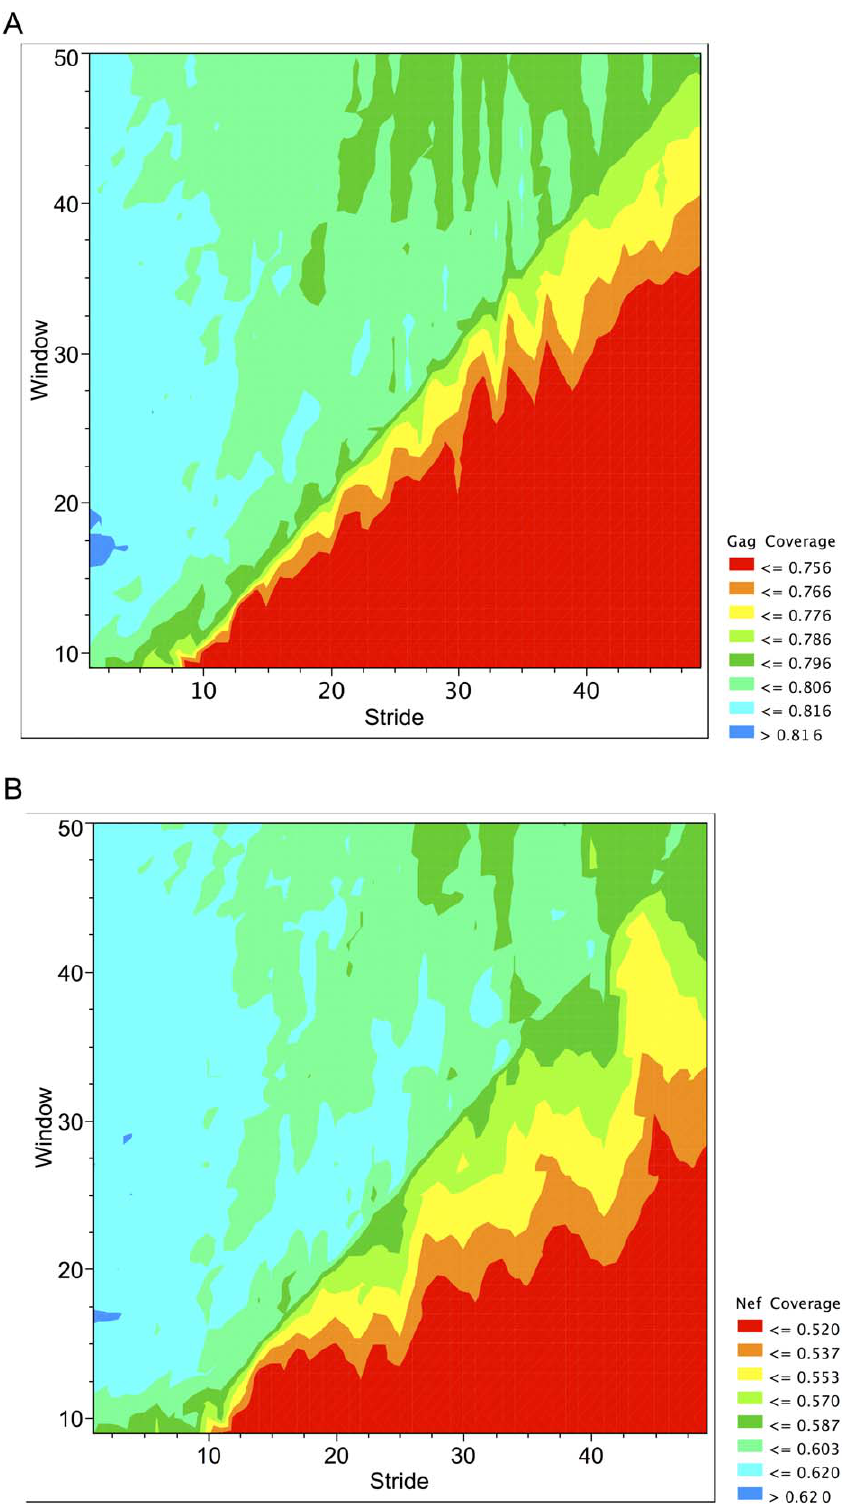
Figure 2. The Effects of Stride versus Window Length on the Measure of Coverage In each graph a three-gene-length COT þ construct is evaluated for coverage. Cold (blue) colors indicate high levels of coverage, and hot (red) colors indicate low levels of coverage. The diagonal in the topography represents the transition from strides shorter than window length to strides longer than window length. The maximal coverage at three gene lengths occurs with a window size of 17 with a stride of 1 with no smoothing for both genes— where 82% of the 9mer area is captured for Gag (A) and 62% of the 9mer area is captured for Nef (B). It should be noted that in the area of window of 17 and a stride of 1 the surface is quite flat, and there are several pairs of parameters that give similar results.